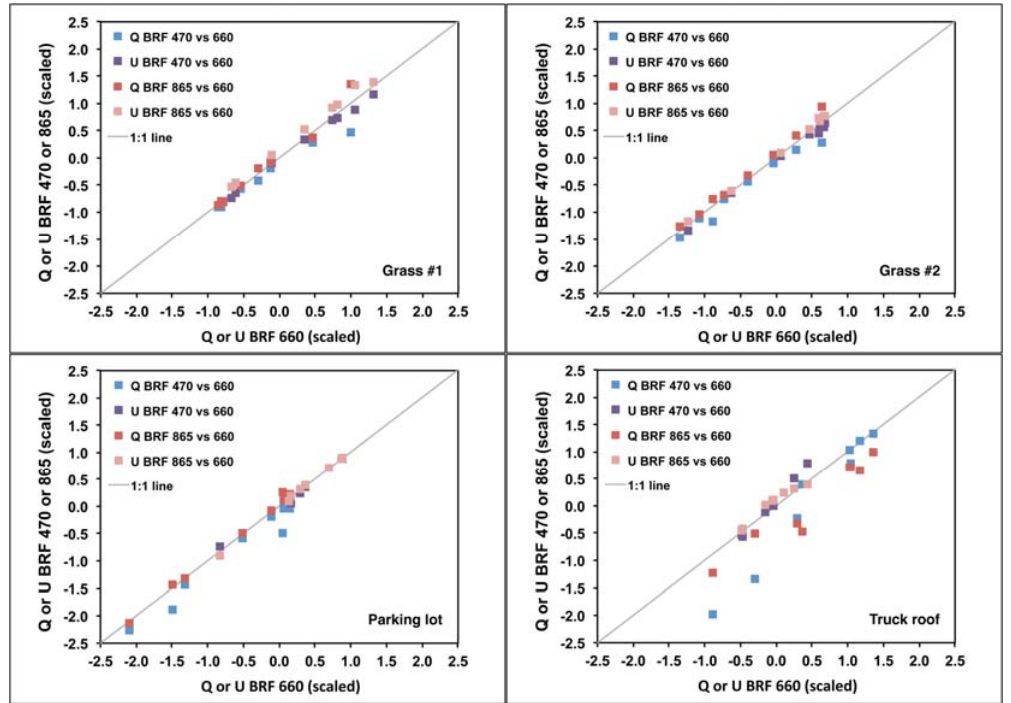
Figure 16. Polarization-domain BRFs at 470 and 865 nm, normalized by the spectrally invariant ξ scale factor, plotted against corresponding values at 660 nm. The various points correspond to data acquired at different times of day. The majority of points fall on the 1:1 line, indicating that both the magnitude and angular shape of the BRFs are spectrally neutral. The largest departures are observed for the truck